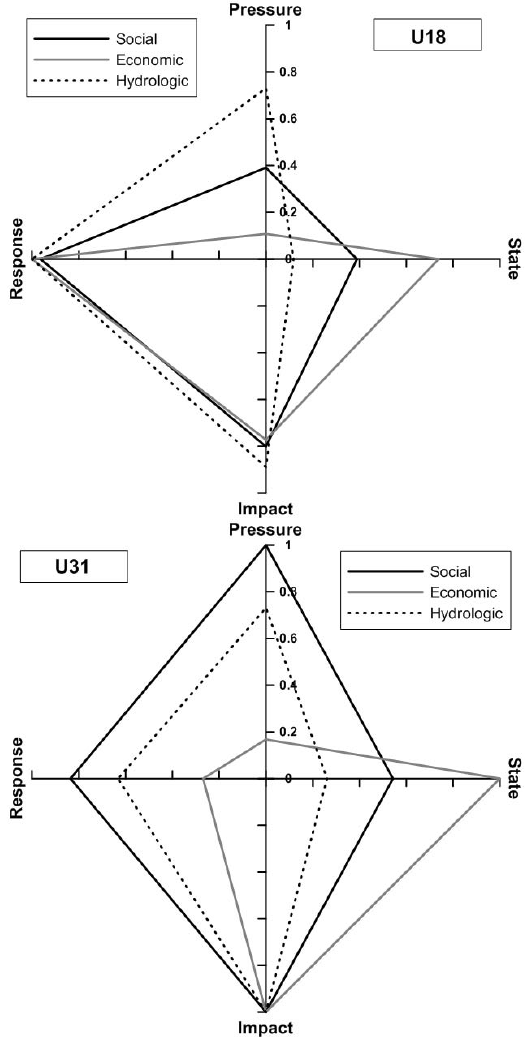
Fig. 12. Comparison of pressure-state-impact-response values (U18 and